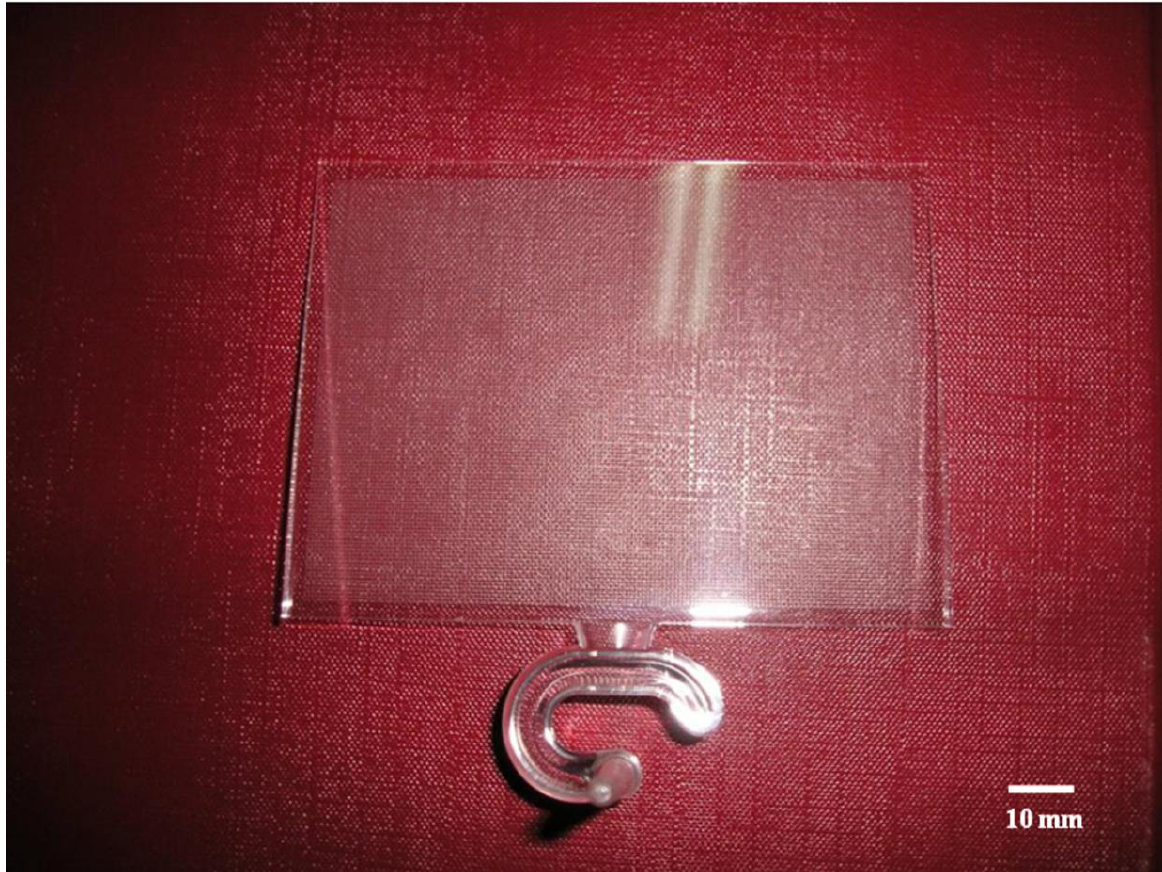
Figure 9. The molded light guiding plate.